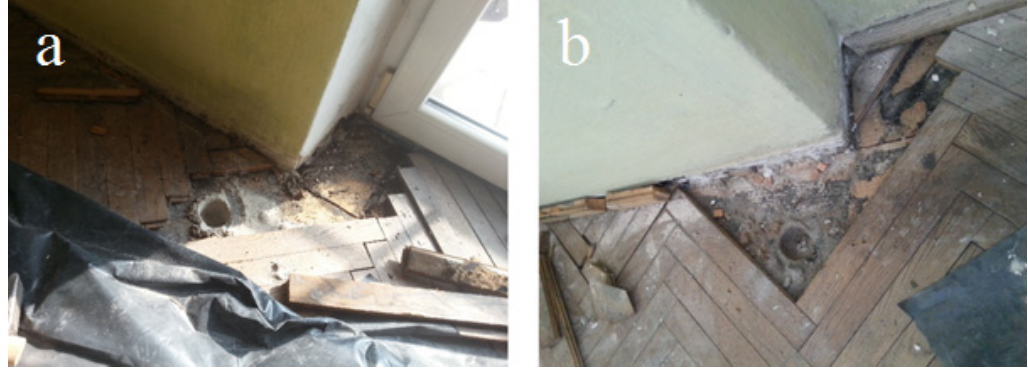
Figure 3. Floor material sampling points in two different (a) and (b) residential buildings (photos taken by the authors).